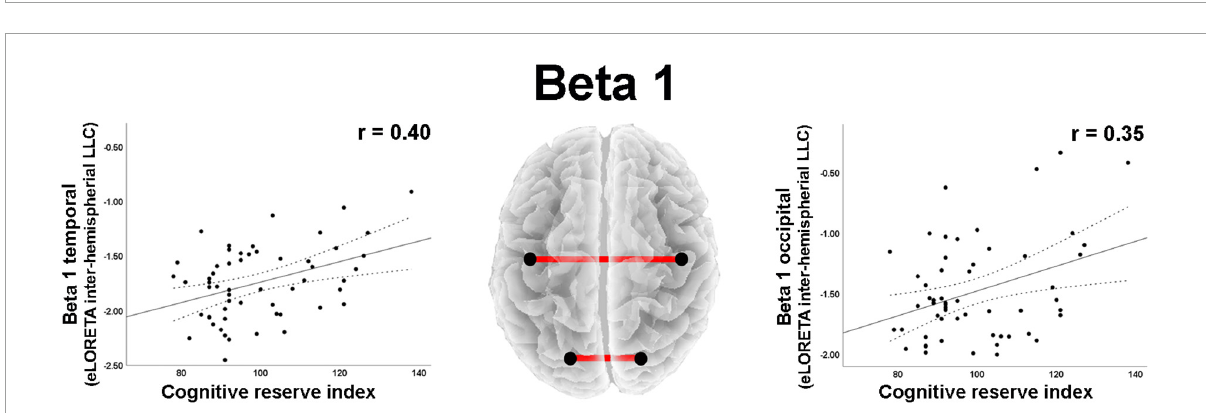
FIGURE4 Graphs and scatterplots with Pearson’s r representing the connections (LLC measures) showing moderate size correlations between interhemispheric LLC estimates and the Cognitive Reserve Index ( r ≥ 0.30). The two correlations were positive (red lines).